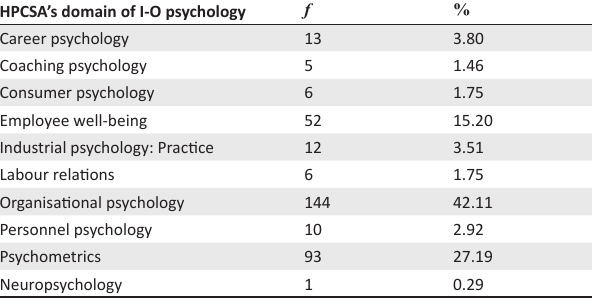
TABLE 4: HPCSA’s domains of I-O psychology.